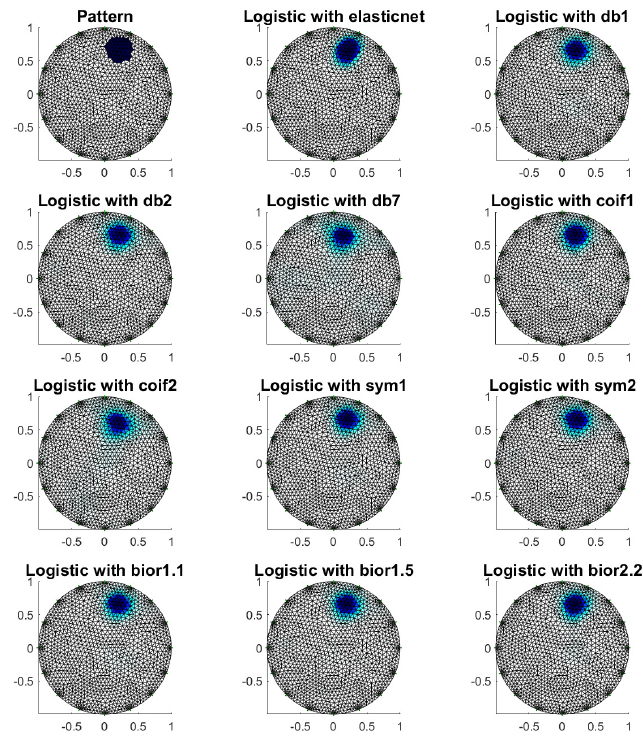
Figure 8. Image reconstruction for one object—example 2.